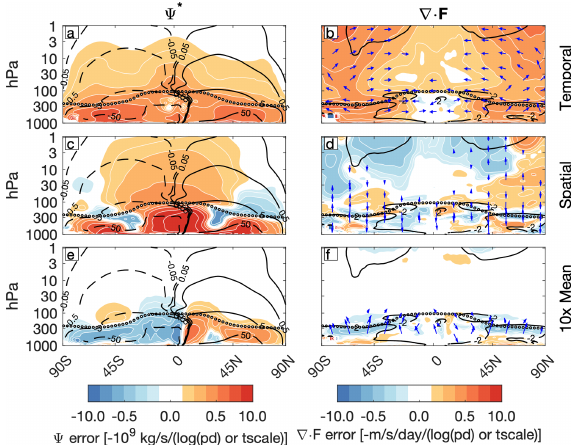
Figure 12. Negative of the projection of (a, b) root-mean-square temporal error, (c, d) root-mean-square spatial error, and (e, f) mean error in the (a, c, e) TEM streamfunction and (b, d, f) EP flux and divergence onto the (a, b, c, d) logarithm of meteorology frequency and (e, f) nudging timescale. Projection in shading (logarithmic scale), climatology in contours, and EP flux in vectors, scaled as in Edmon et al. (1980). In panels (a) , (c) , and (e) the climatologi- cal TEM streamfunction is contoured 0.05, 0.5, 5, and 50 × 10 9 kg per second, with positive values solid and negative values dashed. In panels (b) , (d) , and (f) the climatological EP flux divergence is contoured every 2m per second per day, with negative values solid. The tropopause is shown by the black and white dotted